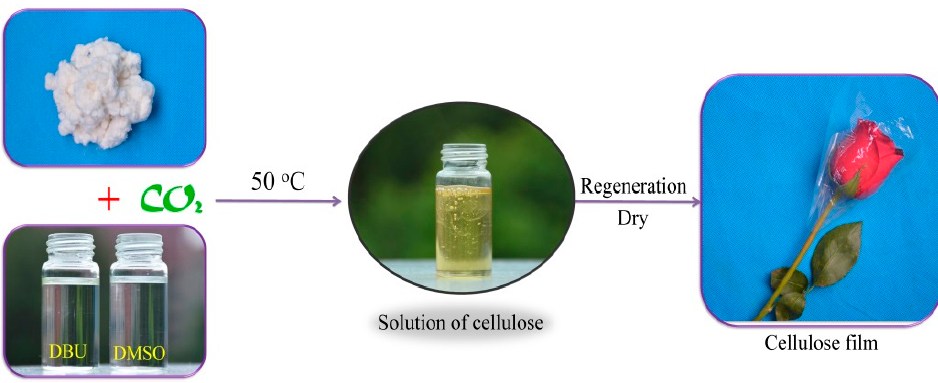
Figure 1. Flowchart of the experiment